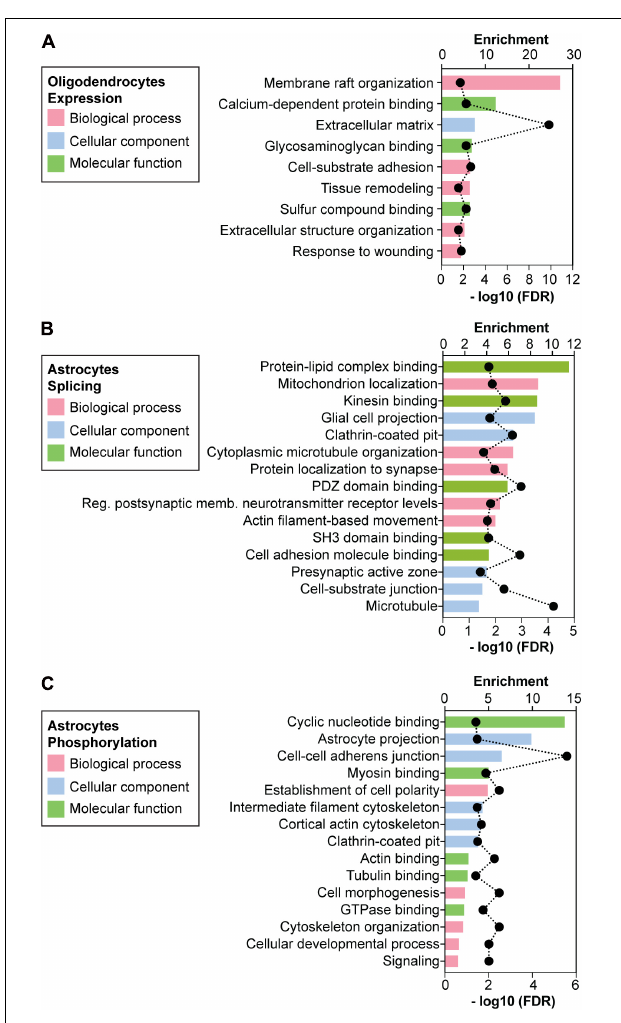
FIGURE 4 | Gene ontology of expression, splicing and phosphorylation changes detected in primary DMSXL cells. Enriched non-redundant GO terms associated with the genes showing (A) altered expression levels in primary DMSXL OL, (B) variations in alternative splicing in primary DMSXL astrocytes, and (C) changes in protein phosphorylation in primary DMSXL astrocytes. The graphs represent the enrichment ratio and the -log10(FDR) of enrichment. A maximum of 5 terms are presented for each ontology (biological process, cellular component and molecular